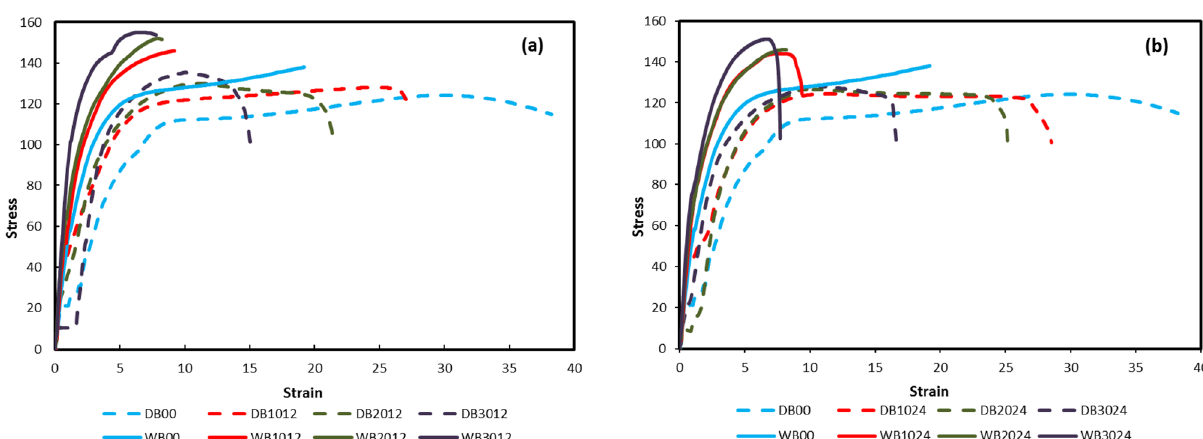
Figure 11. Stress–Strain curves of Polypropylene and Glass fiber reinforced Polypropylene in both dry and wet conditions for; ( a ) LFRPP and ( b )